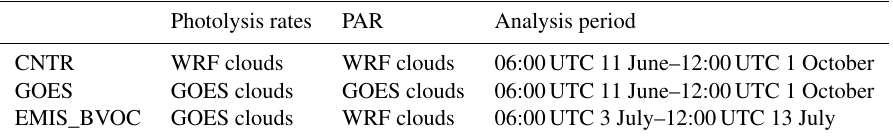
Table 1. Description of WRF-Chem simulations.